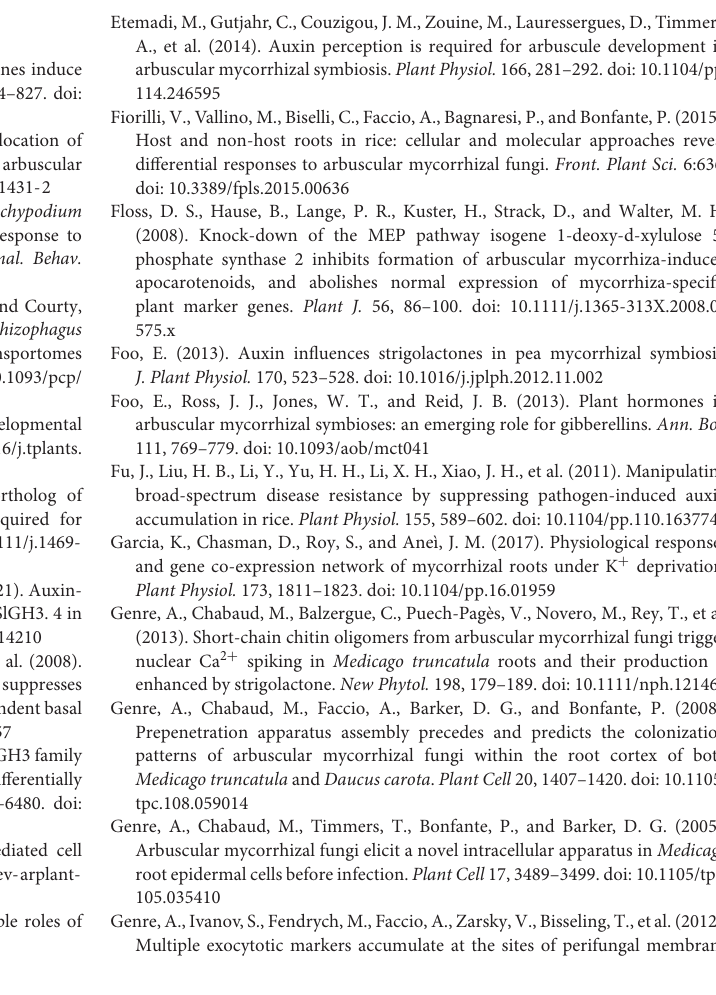
Supplementary Figure 6 | Osgh3.2 mutants exhibited altered panicle architecture and longer grain length. (A,B) Images of mature panicles and grains of wild-type rice and the Osgh3.2 mutants. Scale bars, 1 cm. (C) Statistical analysis of panicle length, primary panicle branches and secondary panicle branches among wild -type and Osgh3.2 mutants, six biological replicates were included. (D) Statistical analysis of grain length, grain width and grain thickness among wild type and Osgh3.2 mutants. Data are individual values from six biological replicates; the horizontal lines indicate the mean values. Different letters indicate statistically significant differences (Student’s t -test, P < 0.05). Supplementary Figure 7 | An exemplar image of rice root fragment colonized by R. irregularis after stained with ink-vinegar solution. The image showed how the longitudinal lengths of arbuscules and cells were measured. Scale bar = 50 µ m. Supplementary Figure 8 | Arbuscule populations at 7- and 9-wpi by R. irregularis in roots of wild-type rice and the Osgh3.2 mutants. (A,B) The longitudinal lengths of 300 arbuscules from three rice individuals were measured (100 arbuscules per individual) at 7- and 9-wpi, respectively. Arbuscules were classified into three categories according to the longitudinal length, small/degenerate ( < 30 µ m), middle (30–50 µ m), and large ( > 50 µ m). Data represent means ± standard deviation (SD). Different letters indicate significant differences (Student’s t -test, P < 0.05). Supplementary Table 1 | The 250 GH3 genes identified from 26 surveyed plant genomes. Supplementary Table 2 | The primers used in this